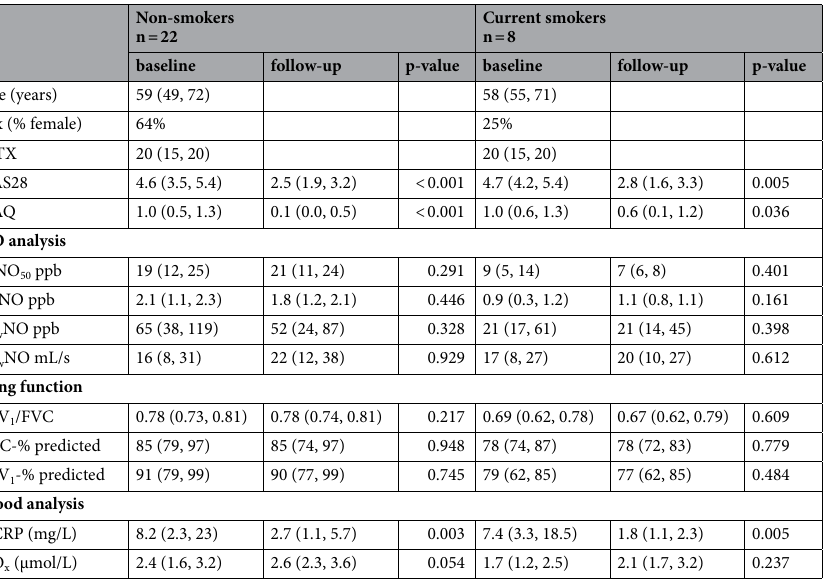
Table 2. Characteristics of smoking and non-smoking patients in Protocol B. Data given in median (lower and upper quartiles). MTX, methotrexate; DAS28, disease activity score for 28 joints; HAQ, the Swedish version of the Stanford Health Assessment Questionnaire; F E NO 50 , fraction of exhaled nitric oxide at the flow of 50 mL/s; C A NO, alveolar nitric oxide; C aw NO, nitric oxide content in the airway wall; D aw NO, nitric oxide diffusion capacity over airway wall; FEV 1 , forced expiratory volume at 1 s; FVC, forced vital capacity; s-CRP, serum C-reactive protein; NOx, nitrate/nitrite in